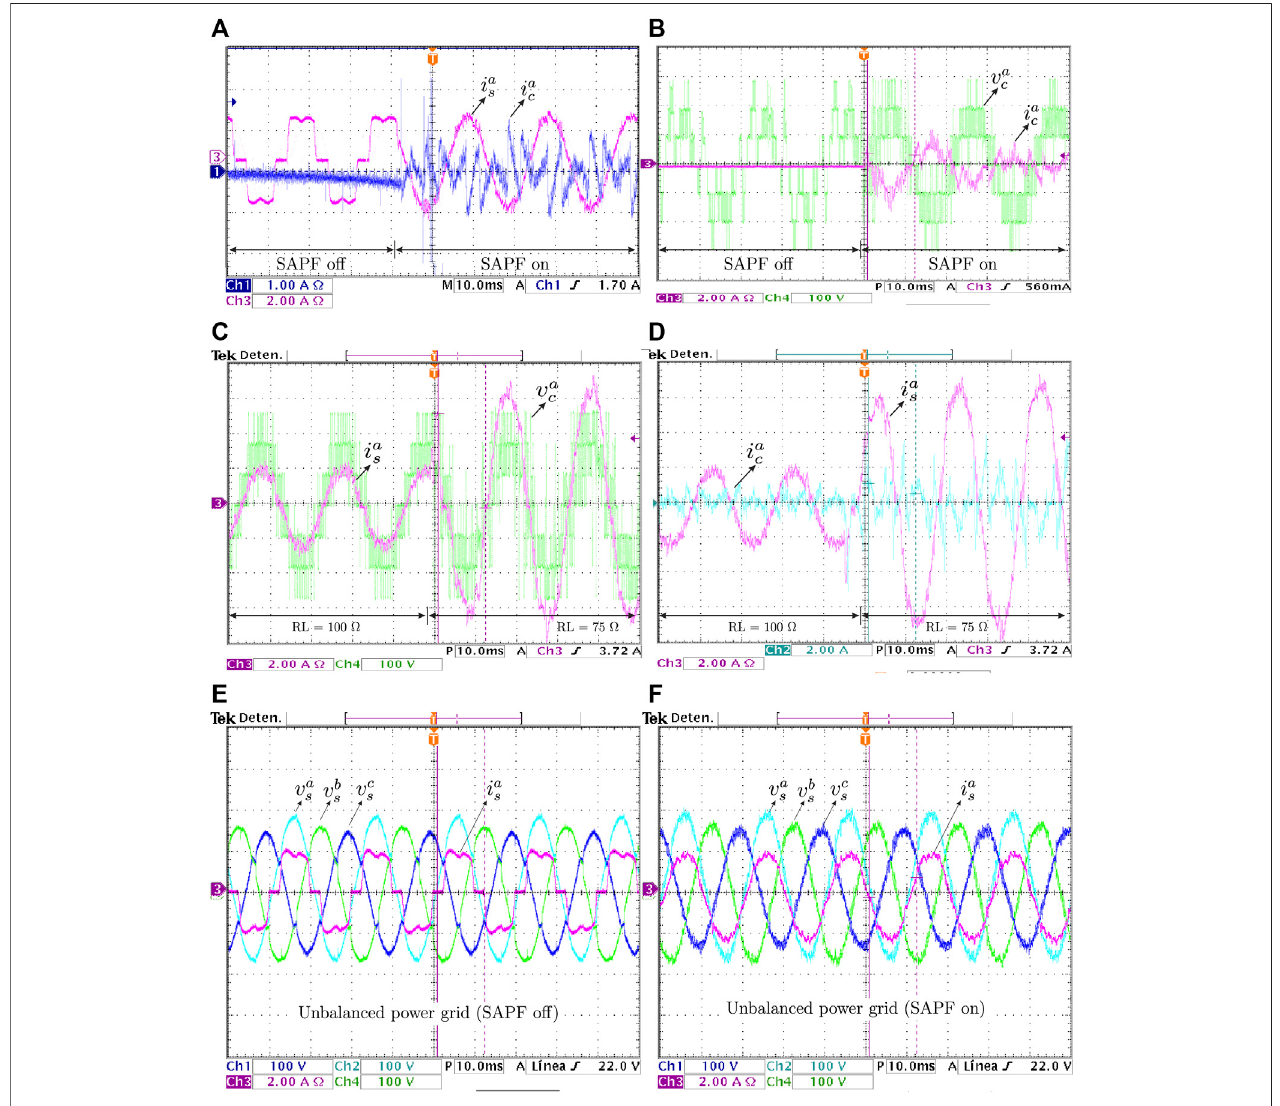
FIGURE 3 | Transient behavior of SAPF (A) source current harmonics compensation, (B) voltage and current output of SAPF, (C) current i a s and voltage v a c for instantaneousloadresistance changes, (D) current i a c and i c s for increased load. Unbalanced voltages (E) uncompensated source current, (F) compensated